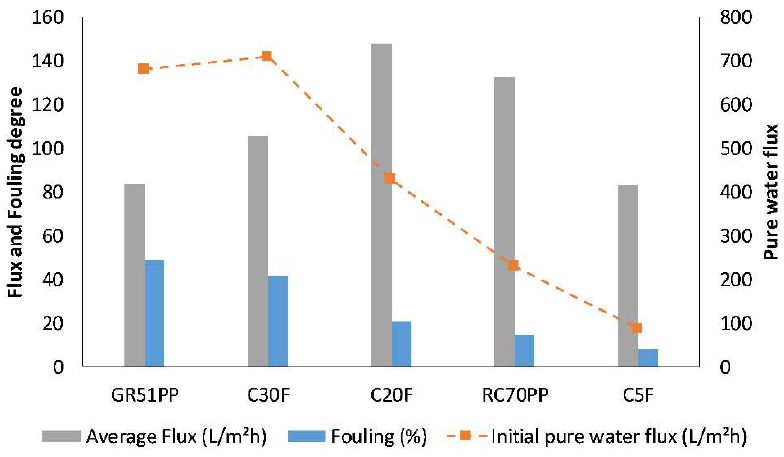
Figure 5. The average flux, fouling degree, and initial pure water flux (new and cleaned membrane) for the studied membranes.